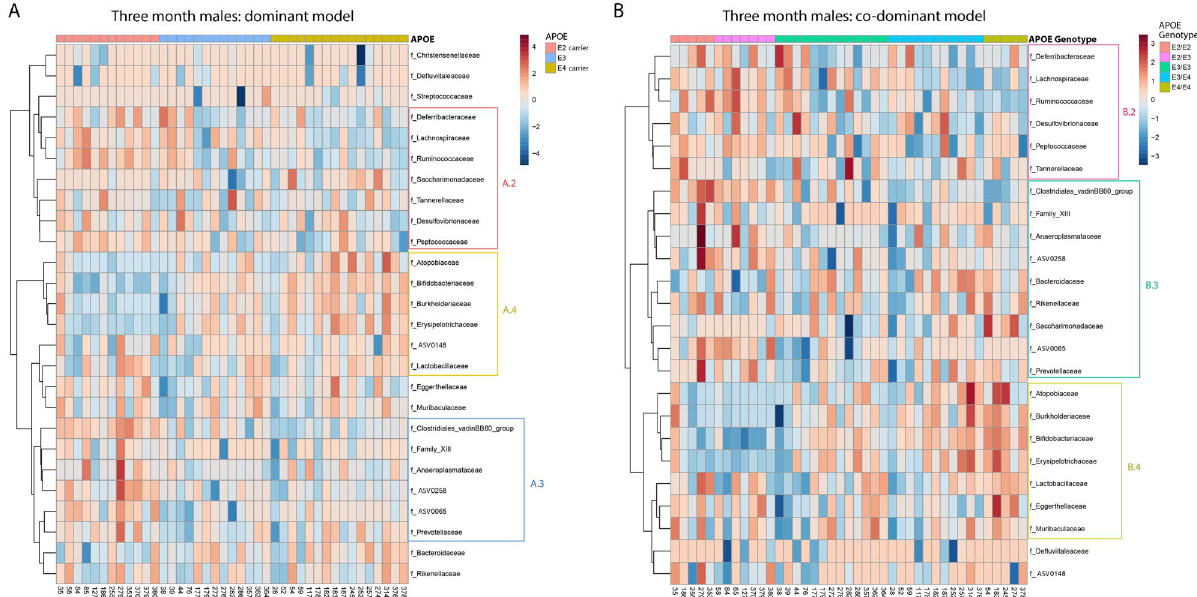
Figure 4. Heatmaps depict overall microbiota profiles grouped by APOE status. These heatmaps depict per- sample relative abundance for family-level bacteria in female and male mice. Columns were grouped by APOE status, rows were grouped by the Ward clustering algorithm using Pearson Correlation Coefficient distance measures. Colored boxes highlight groups of taxa that follow either an APOE2 - (A.2 and B.2), APOE3 - (A.3 and B.3) or APOE4 -associated pattern (A.4 and